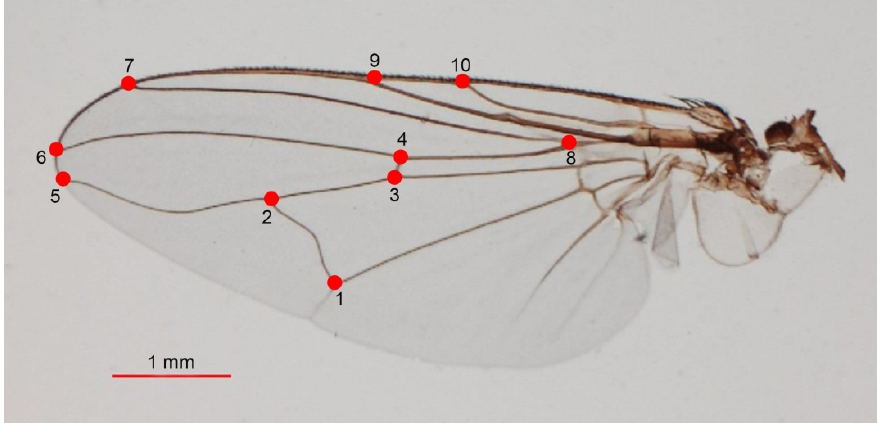
Figure 2. Ten anatomical landmarks selected from the left wing to estimate the phenotypic varia- tion of S. calcitrans based on landmark-based geometric morphometric analysis. of S. calcitrans based on landmark-based geometric morphometric